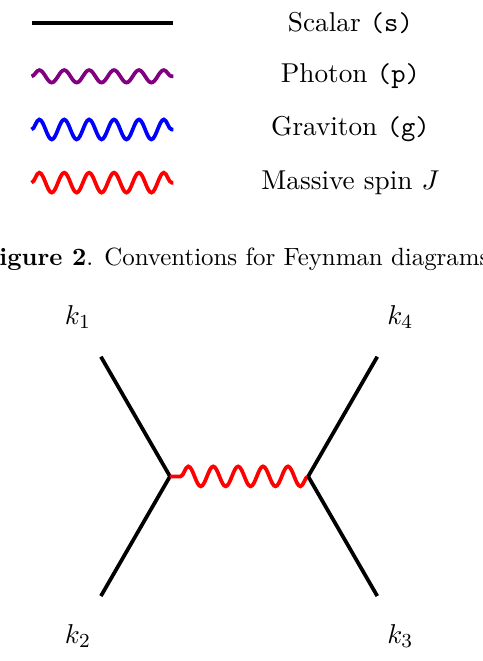
Figure 3 . Four scalar amplitude due to exchange of a massive spinning particle. graviton and a red wavy line to denote a massive spin J particle. These are shown in figure